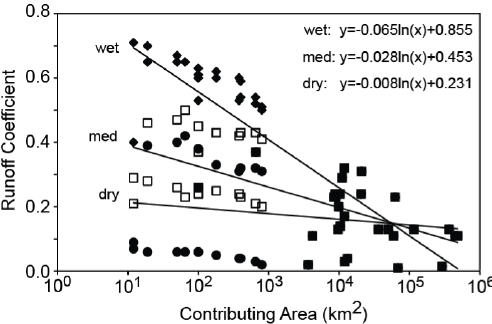
Figure 3. Logarithmic relationships between runoff coefficients and contributing area using modeled data for wet (filled diamonds), medium (open squares), and dry (filled circles) antecedent-moisture conditions (Vivoni et al., 2007) and measured data for larger con- tributing areas (filled squares; Rosenburg et al., 2013). The medium (open squares) and dry (filled circles) data separate into two distinct groups relating to the precipitation event used to model them, with the lower group and higher group relating to a 12h, 1mmh − 1 event and 1h, 40mmh − 1 event, respectively. All points were used in the least-squares weighed-regression